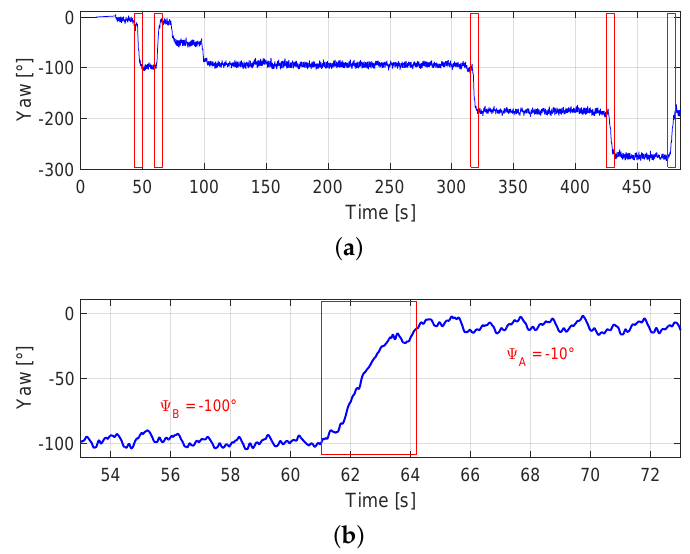
Figure 2. The blue curve represents the yaw angle estimation during a walk where the inertial sensors are placed in the front pocket of the trousers. The detected corners are highlighted in red. ( b ) depicts a zoom of the second corner of ( a